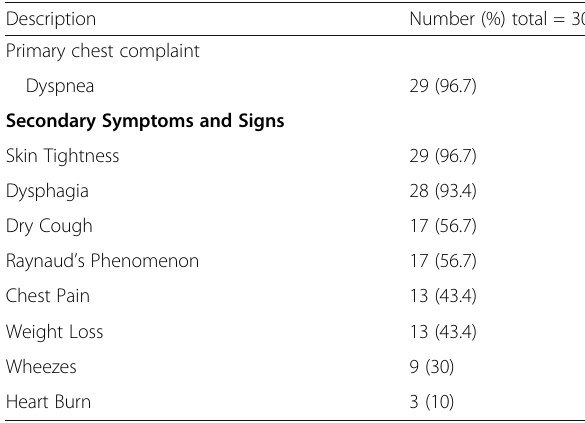
Table 3 Different symptoms and signs in systemic sclerosis